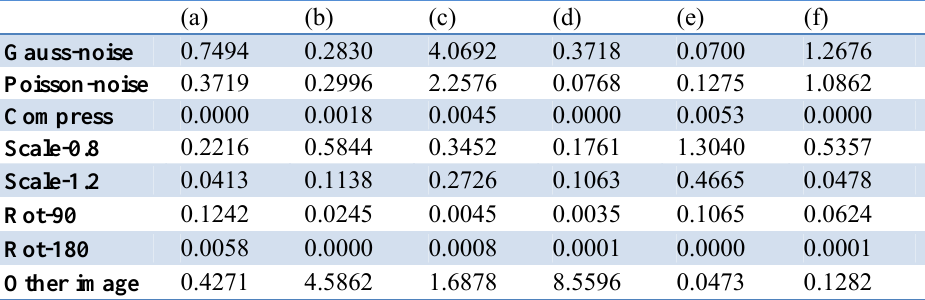
Table 6 Similarity value of the transfer